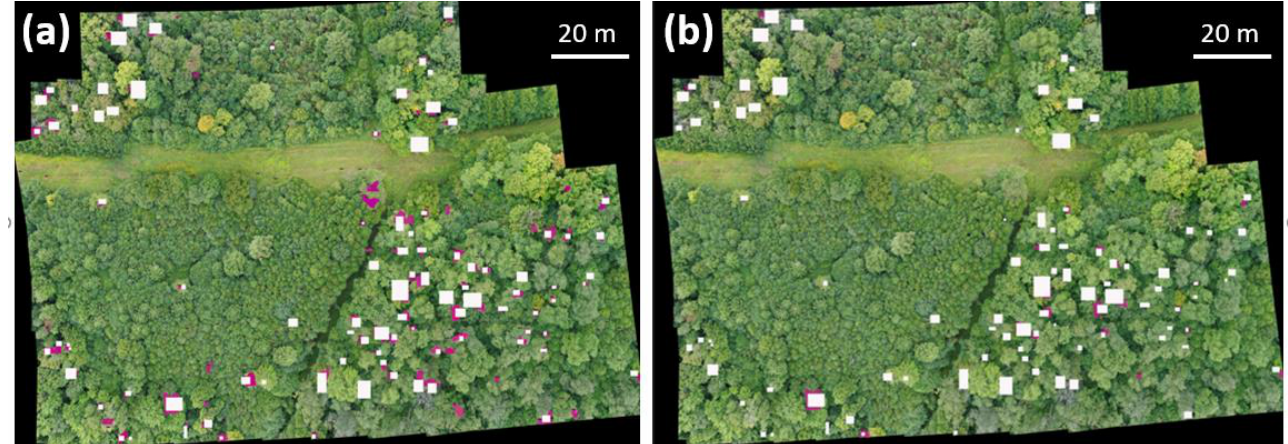
Figure 4. Example in-situ validation for the detection of declining or dead ash trees using Mask2for- mer, a supervised deep learning model with two different confidence levels: 0.1 ( a ) and 0.5 ( b ). White boxes indicate declining or dead ash trees located by ground survey, and purple areas (bounding box) indicate declining or dead ash trees detected and located by Mask2former. By com- paring ground survey data with Mask2former prediction map, type I and II errors could be calcu- lated.